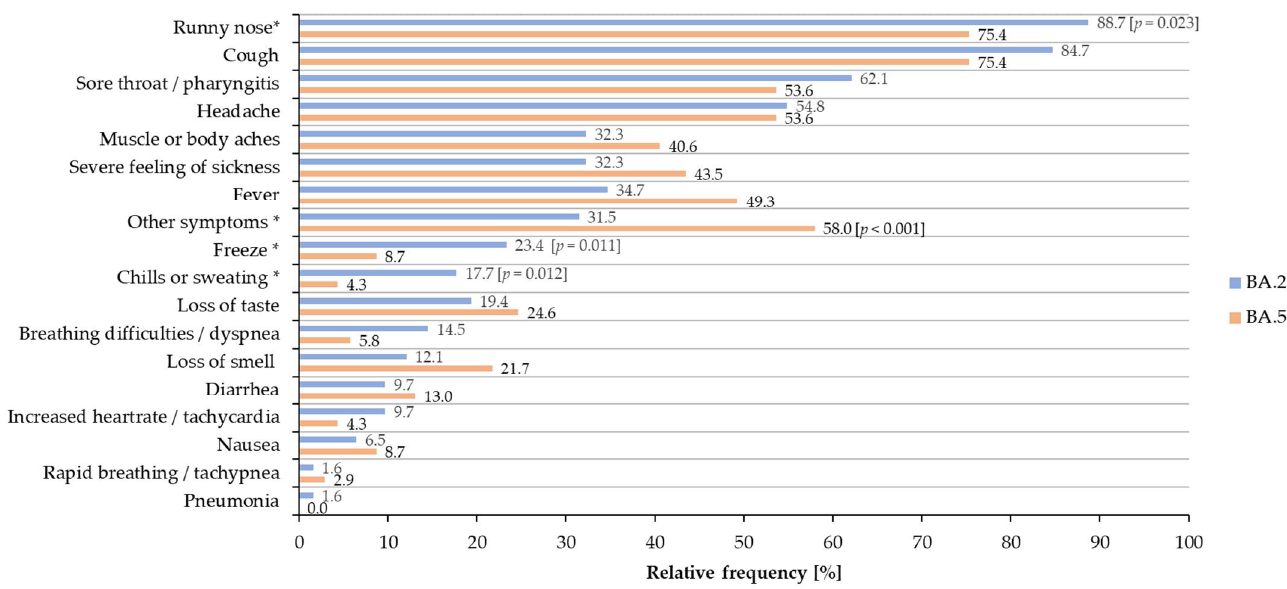
Figure 2. Relative frequency of the most prominent 18 symptoms of infected symptomatic BA.2 and BA.5 cases. * p values are given in squared brackets for significant results.